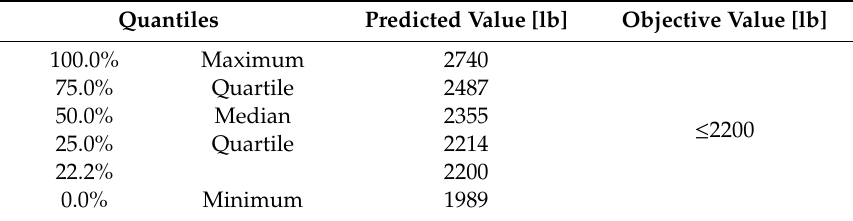
Table 17. Maximum takeo ff weight (MTOW) percentile.